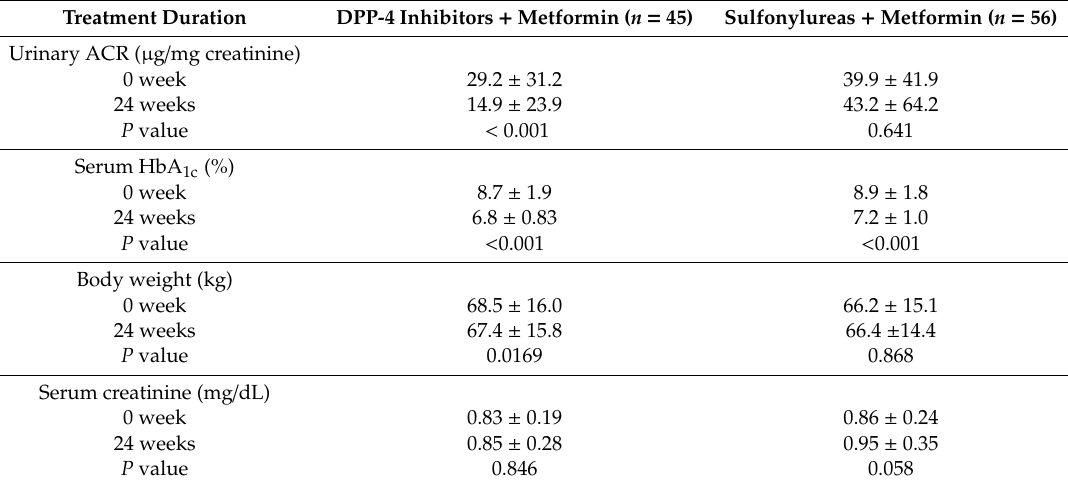
Table 2. Comparison of outcome measures relative to levels at